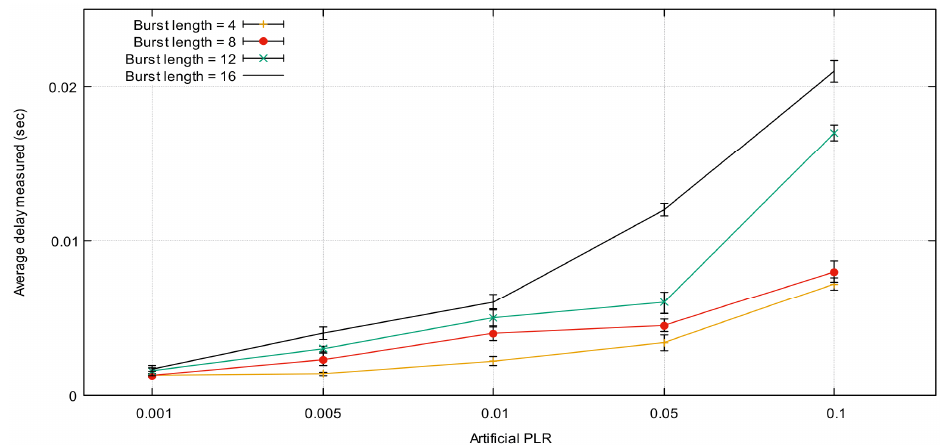
Figure 6. MS-AL-ARQ packet delay (average one-way packet delay) for different packet loss rate (PLR) and burst length (BL) values.